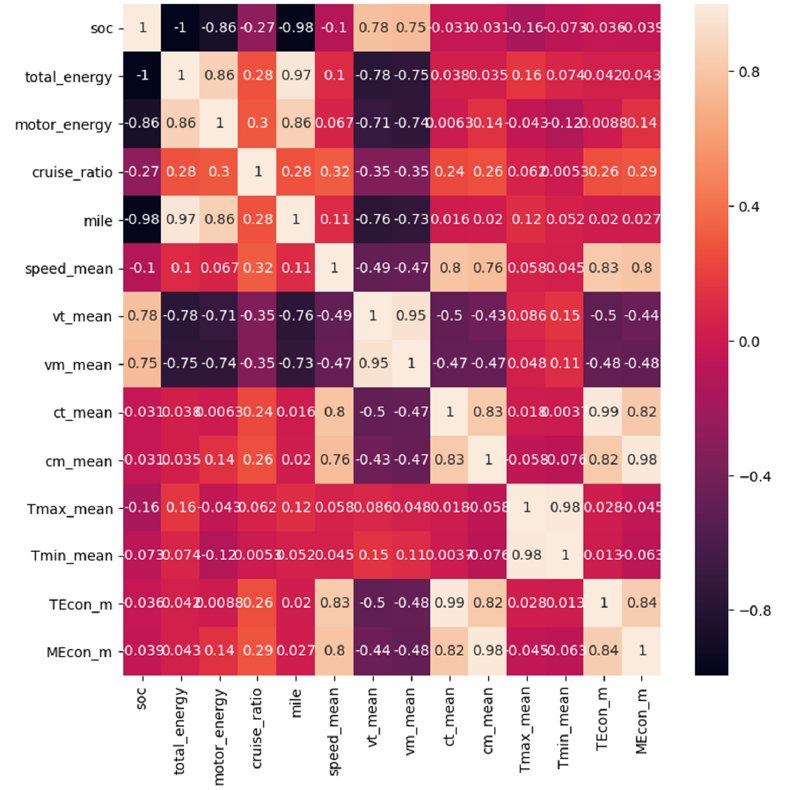
Figure 4. Extended feature correlation